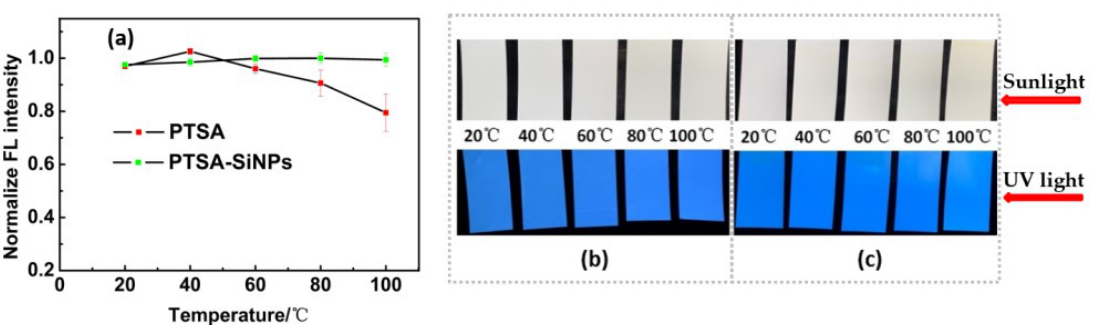
Figure 8. ( a ) Comparison of heat stability of the PTSA-SiNPs and PTSA anti-counterfeit ink; heat stability images of ( b ) PTSA-SiNPs and ( c ) PTSA anti-counterfeit ink samples under sunlight and UV light, respectively.